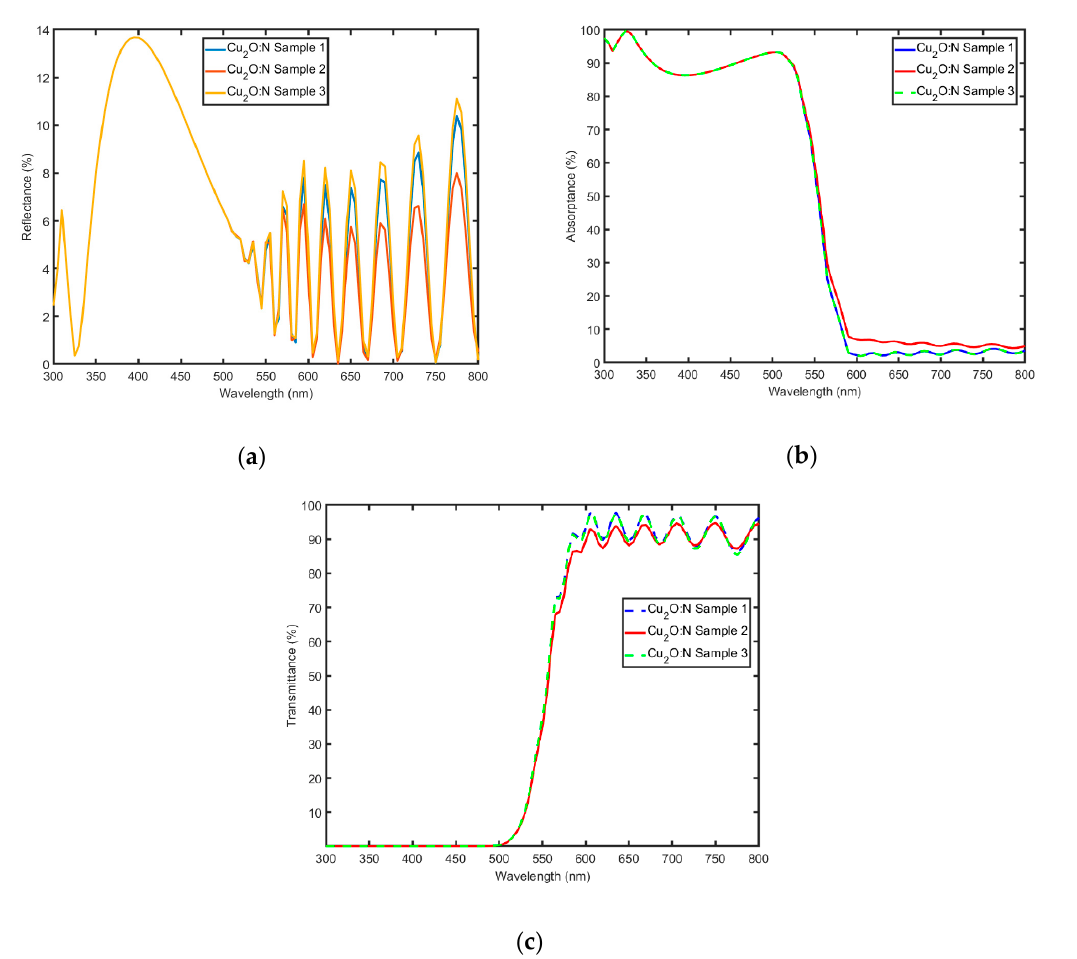
Figure 8. Percentage ( a ) reflectance, ( b ) absorptance, and ( c ) transmittance as a function of wavelength for the metal oxide structure.